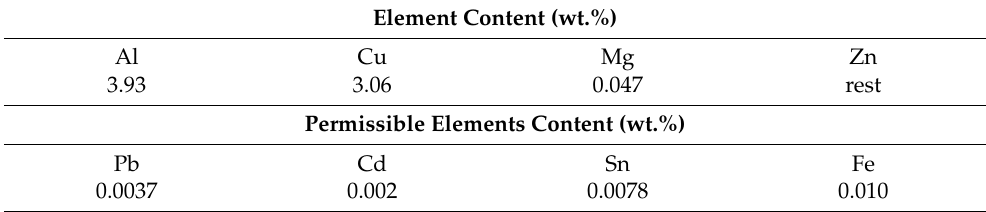
Table 1. ZnAl4Cu3 alloy chemical composition.